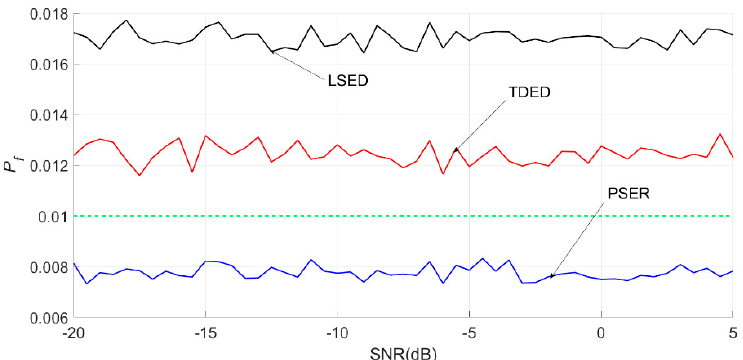
Figure 13. Oscillogram of Ricker wavelet under no noise and noise. f M = 50 Hz. ( a ) Waveform in time domain without noise. ( b ) Power spectrum of ( a ). ( c ) Waveform in time domain with noise, where SNR is − 5 dB. ( d ) Power spectrum of ( c ), and there is a peak on 44 Hz.